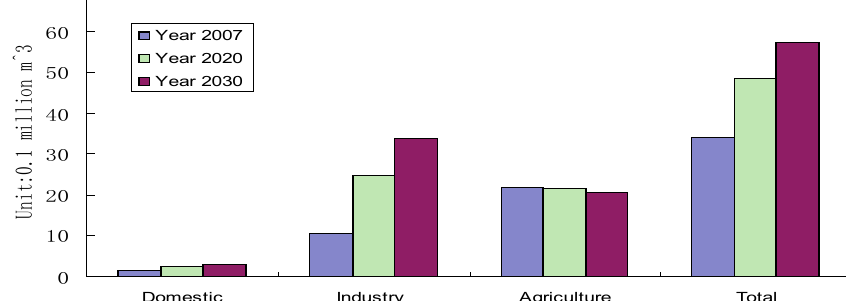
Fig. 6 Water supply volumes of inner and outer river in current year and planned level